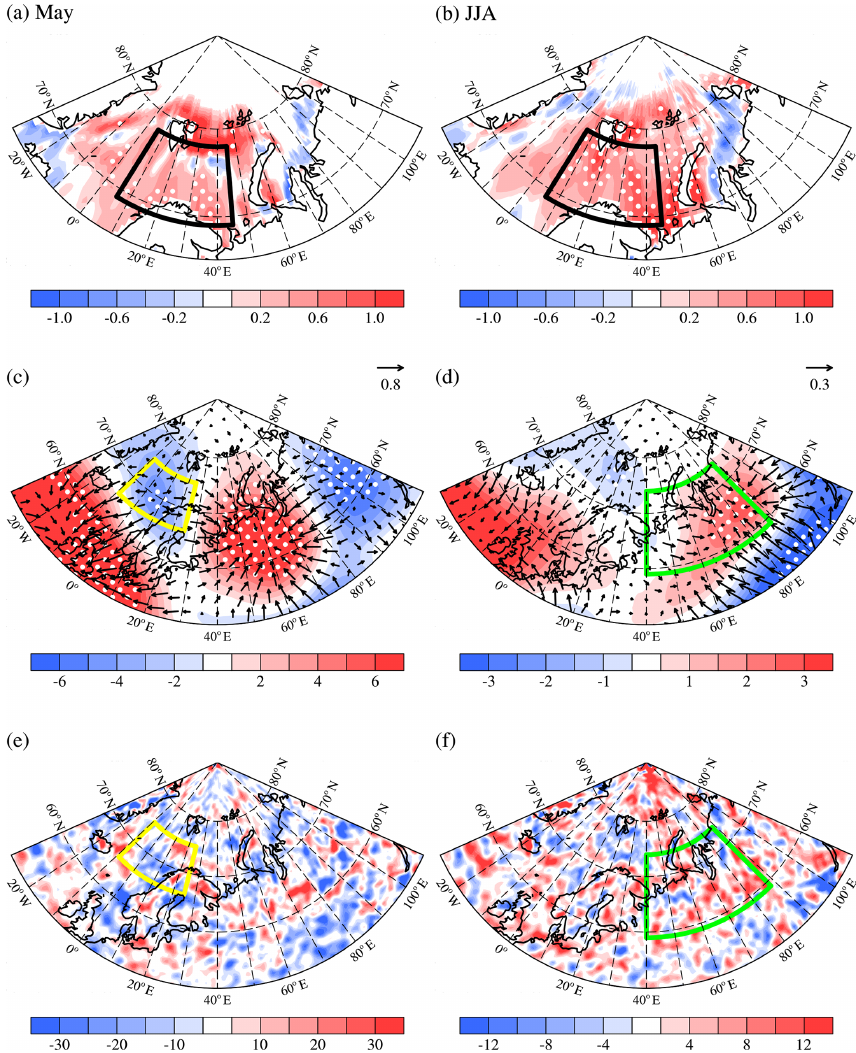
Figure 5. Composites of (a) May Arctic SST (unit: K), (c) velocity potential (unit: 10 5 m 2 s − 1 , shading) and divergent wind at 500hPa (unit: ms − 1 , arrows), and (e) Rossby wave source anomalies at 500hPa (unit: 10 − 11 s − 2 ) associated with SI FJL index (negative SI FJL years minus positive SI FJL years) from 1980 to 2019. The black box in (a) and (b) , yellow box in (c) and (e) , and green box in (d) and (f) represent the center of the SST, velocity potential, and Rossby wave source anomaly associated with SI FJL , respectively. The white dots indicate that the composites with shading were above the 90% confidence